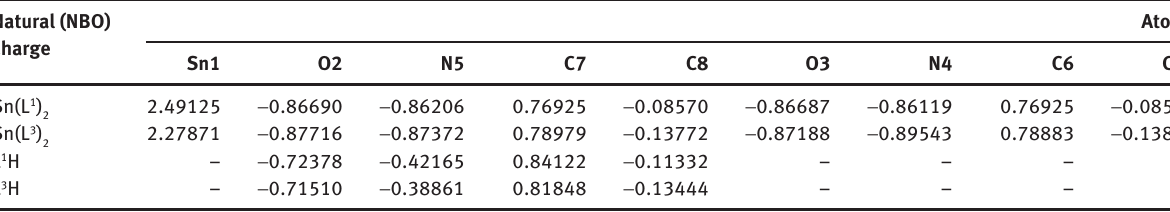
Table 7: Atom characteristics charge, in terms of NBO analysis, a comparison between ligands and their complexes. Natural (NBO)